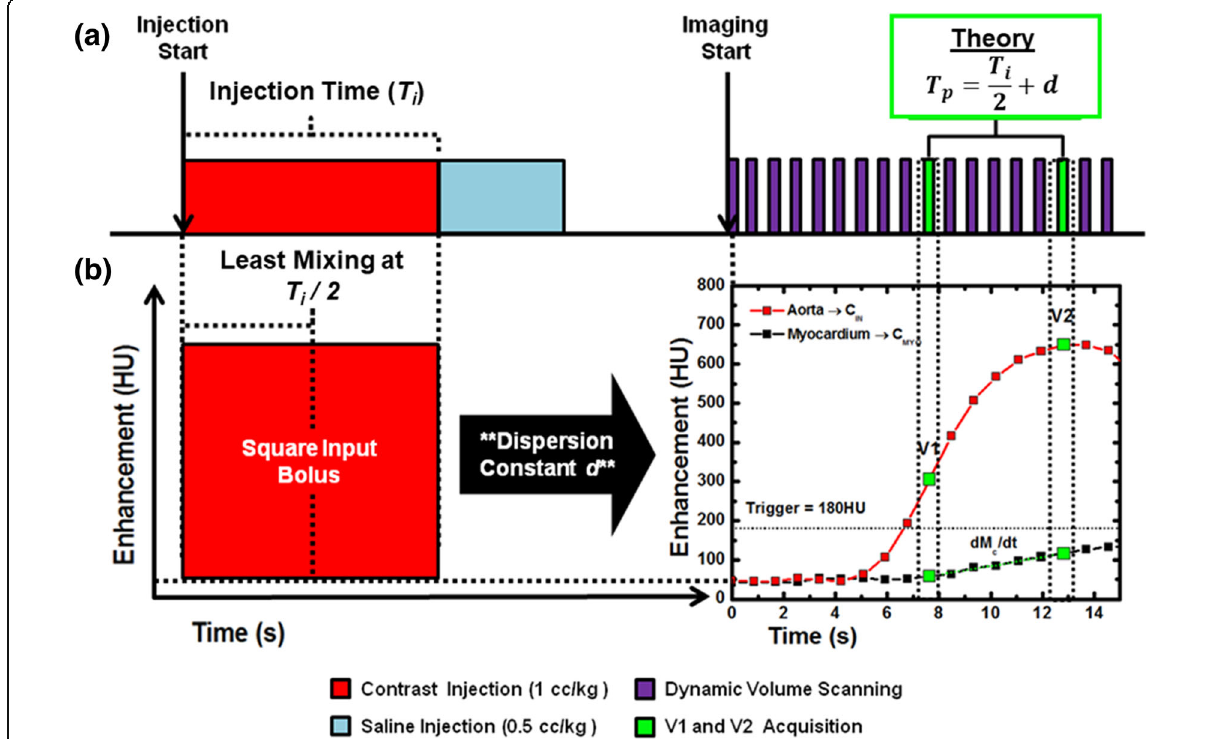
Fig. 1 Contrast bolus injection protocol and bolus dispersion theory. a For all contrast-enhanced imaging, contrast was injected at a fixed rate, followed by a saline chaser at the same rate. Dynamic imaging of the heart was then performed. b The contrast bolus dispersion and optimal peak timing theory states that the peak enhancement of the contrast bolus in the aorta occurs at approximately one half the injection time plus þ d). Note that the V2 volume scan also corresponds to the site of optimal CT a fixed dispersion delay ( T i 2